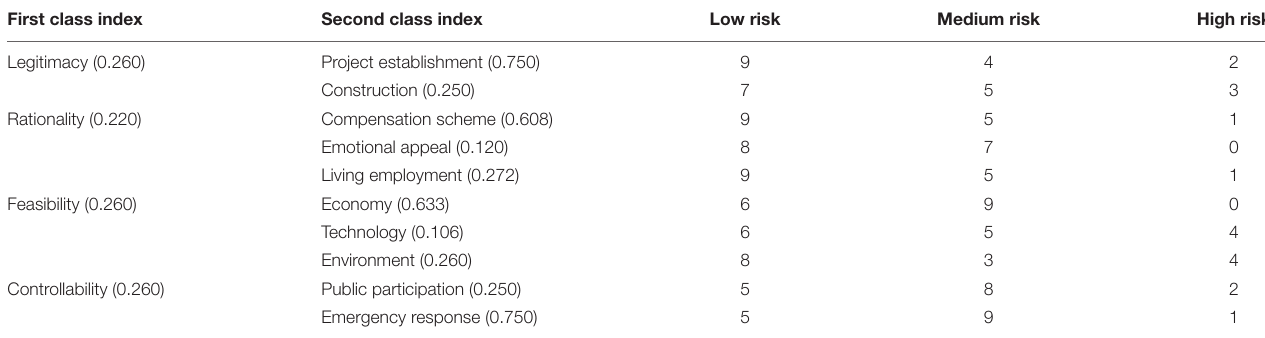
TABLE 4 | The evaluation criteria system and